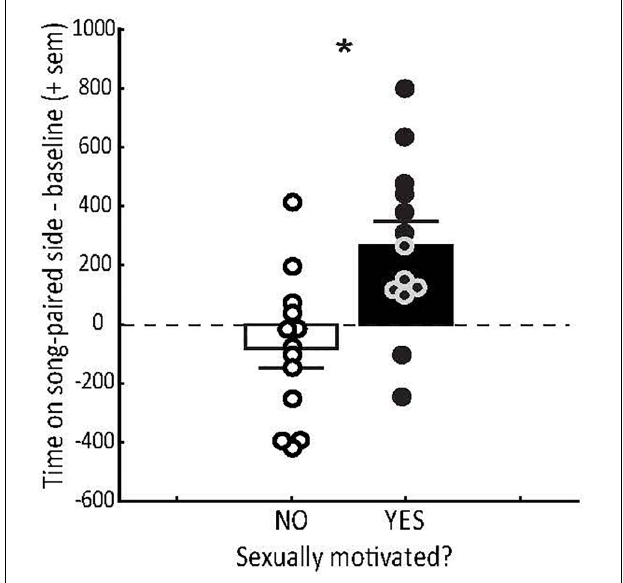
FIGURE 2 | Conditioned place preference (CPP) tests demonstrate that hearing sexually motivated song induces a positive emotional state in sexually motivated females. Mean (+ sem) time spent (in the absence of song playback) on the side of the CPP apparatus previously paired with male starling courtship song (minus the baseline preference for that side during habitation) in female starlings that were not (open bar) or were (filled bar) sexually motivated as indicated by exploration of nesting sites. Each point represents data from a single female. Zero on the y axis indicates no preference. * = p < 0.0027. Figure redrawn from Riters et al.